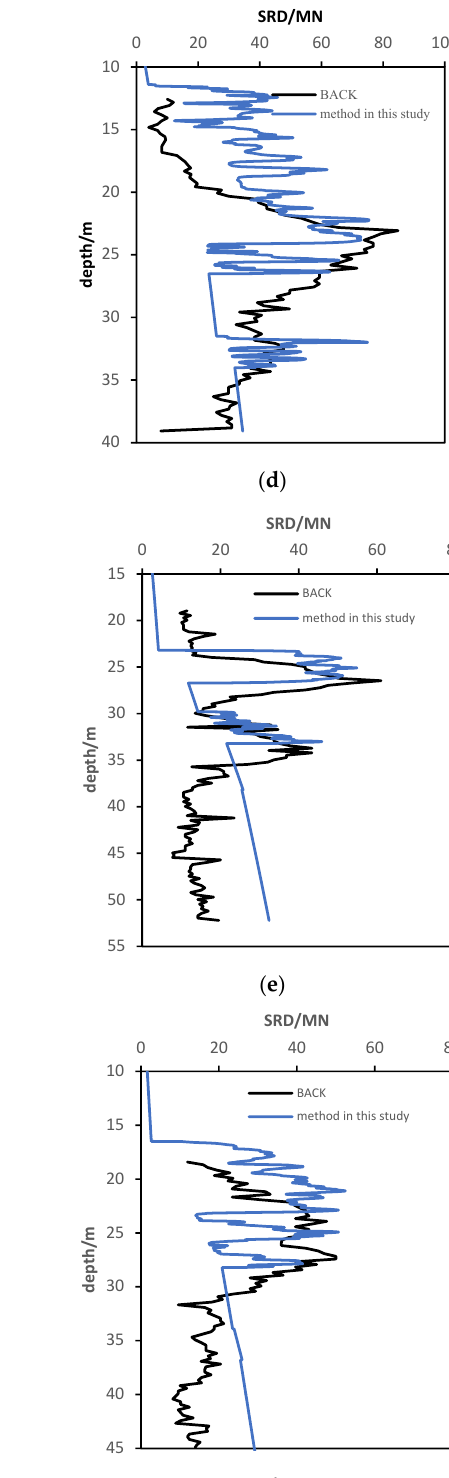
Figure 7. Comparison of the SRDs obtained by back analysis and by modified method. ( a ) Case 1